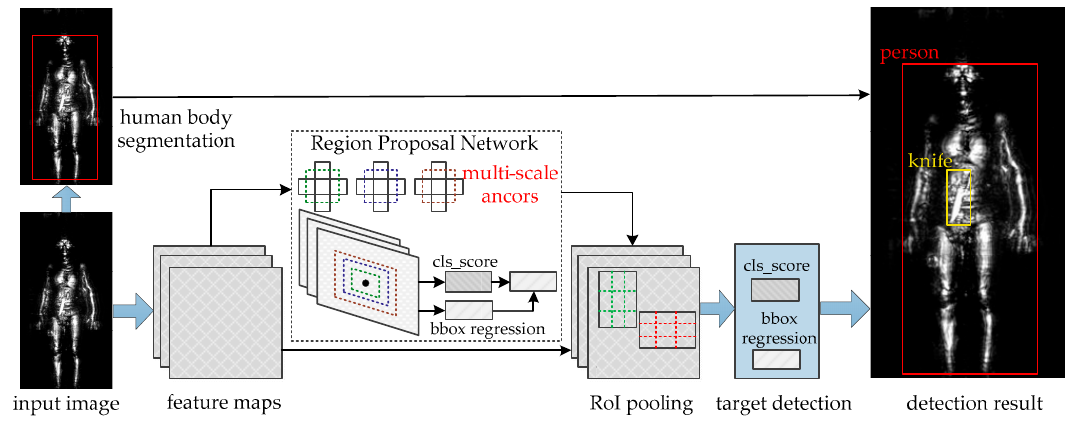
Figure 9. The network structure of the improved Faster R-CNN algorithm.